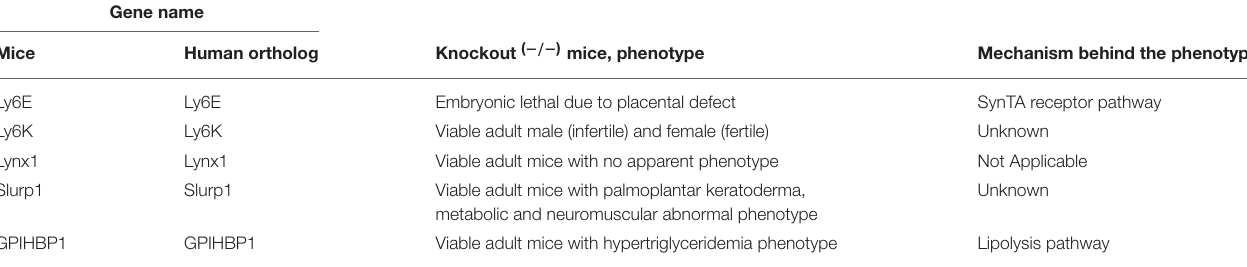
TABLE 1 | The phenotype of knockout mice model of Ly6 gene family